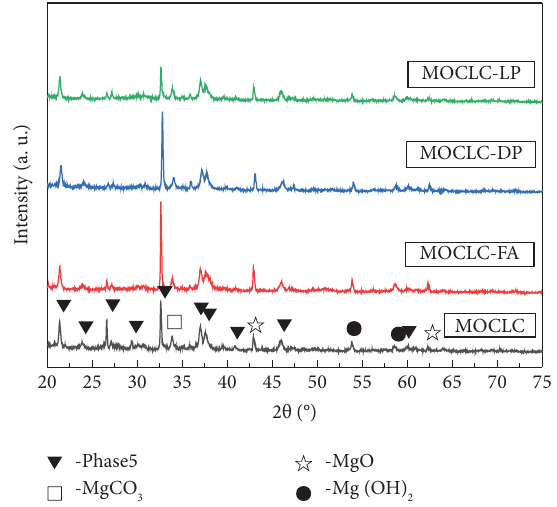
Figure 10: XRD patterns of MOCLC with diferent mineral admixtures.